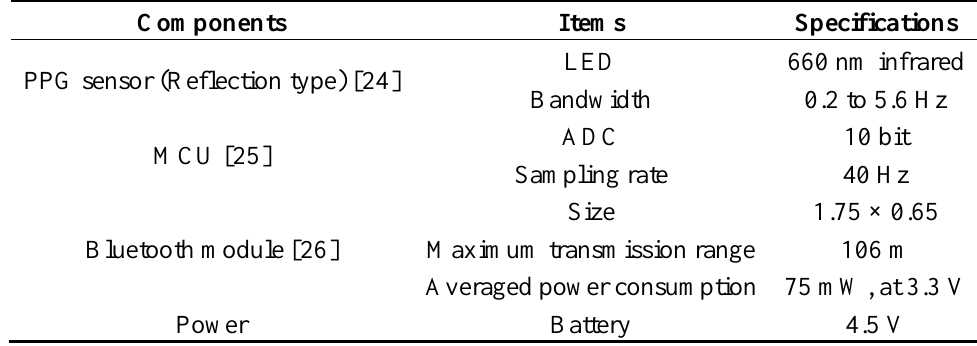
Table 1. Specifications of fabricated PPG wireless sensor